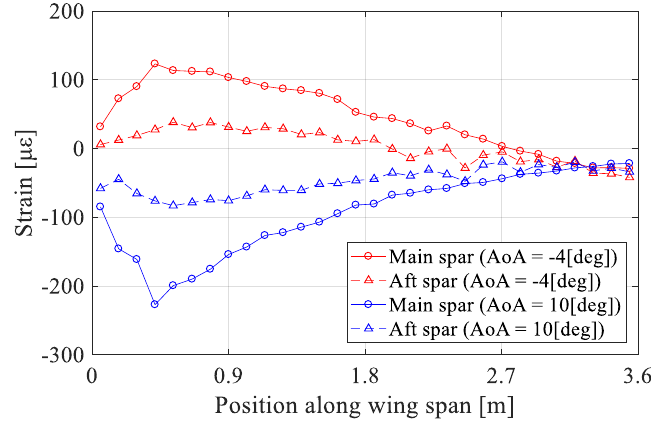
Figure 8. Measured strain distributions at AoA = −4° and 10° in “controlled” test cases.